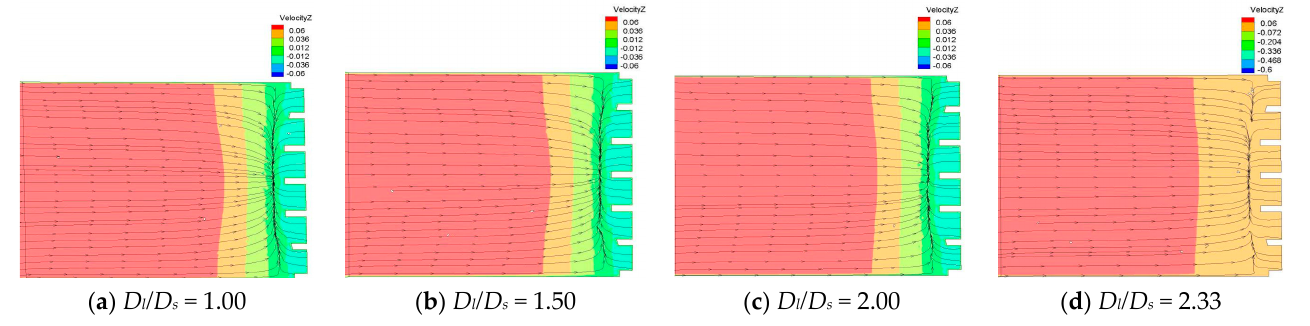
Figure 20. Suction sump axial flow velocity and flow line diagram (section 2-3, unit: m/s).